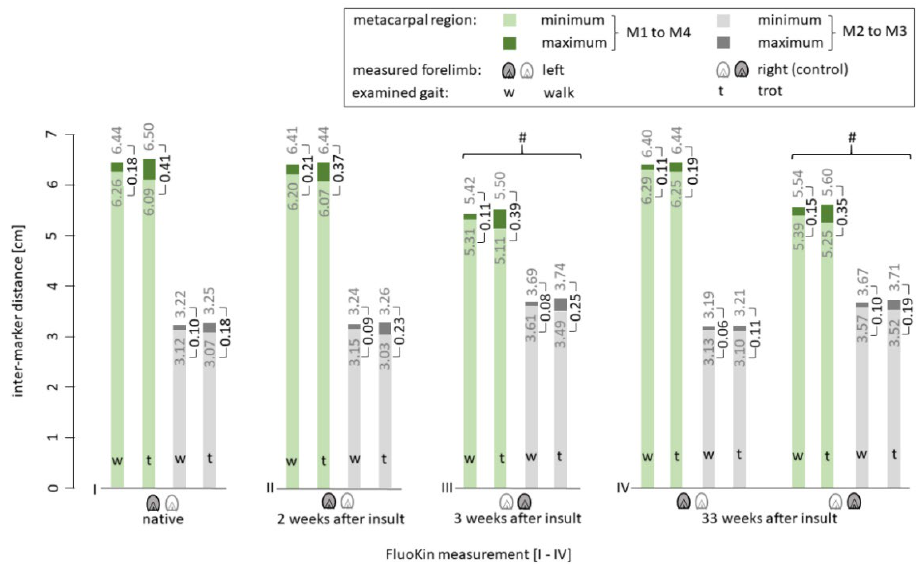
Figure 6. Bar graph of the length variation of the tendon markers of both forelimbs during walk and trot. # indicates nonsignificant differences between corresponding amplitudes in the right, not-insulted forelimb.